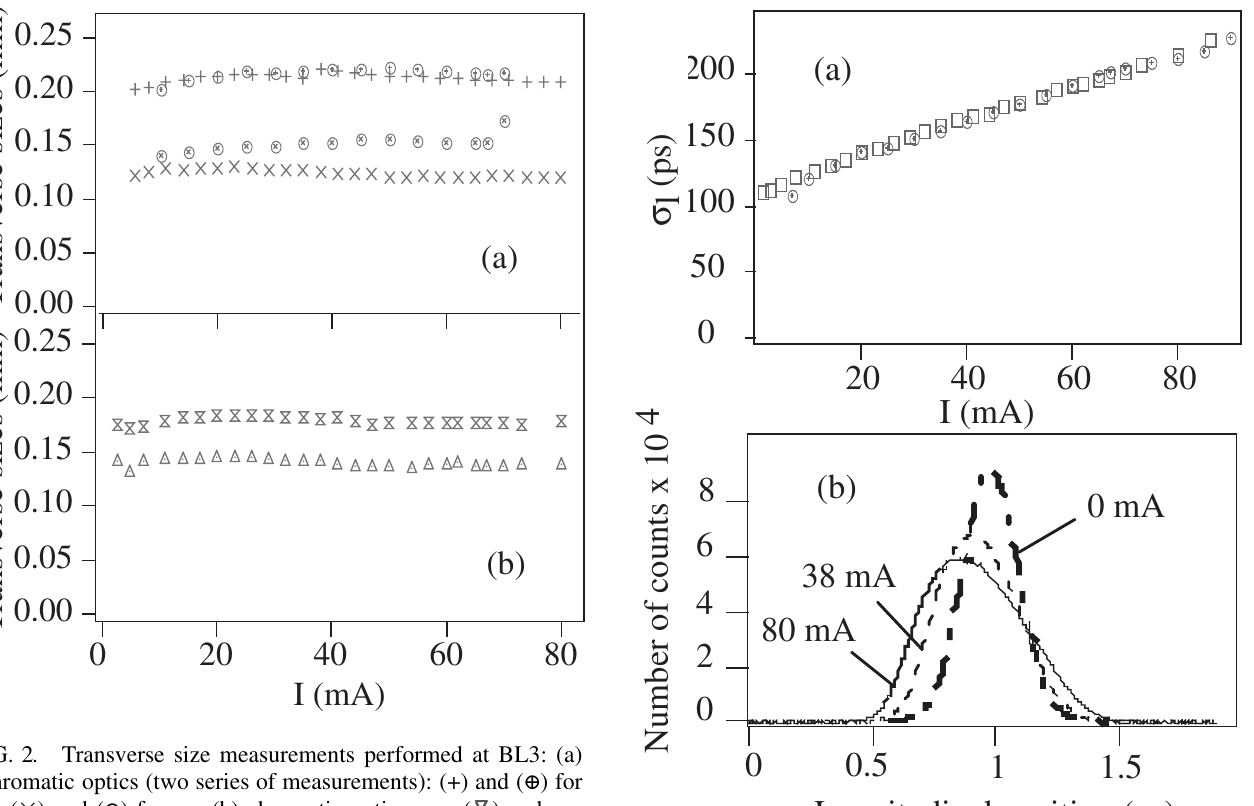
: ( ) and (cid:2) : x z FIG. 3. (a) The rms bunch length versus current, in the achro- matic ( (cid:10) ) and chromatic ( (cid:1) ) cases with FEL off, measured with a double sweep streak camera Hamamatsu C5680. (b) Evolution of the electron beam longitudinal profile for different currents (chromatic case) with FEL off (data analysis from streak camera Hamamatsu C5680 images). Continuous line: I (cid:6) 80 mA , dashed line: I (cid:6) 38 mA , dotted and dashed line: I (cid:6) 0 mA . p (cid:5) , where w (cid:6) (cid:1)(cid:1)(cid:1)(cid:1)(cid:1)(cid:1)(cid:1)(cid:1)(cid:1)(cid:1)(cid:1)(cid:1)(cid:1)(cid:1)(cid:1)(cid:1)(cid:1)(cid:1)(cid:1)(cid:1)(cid:1)(cid:1)(cid:1)(cid:1)(cid:1)(cid:1)(cid:1)(cid:1)(cid:1)(cid:1)(cid:1)(cid:1)(cid:1)(cid:1)(cid:1)(cid:1)(cid:1)(cid:1)(cid:1)(cid:1) (cid:4) e(cid:7)V (cid:5) = (cid:4) T =w w E (cid:5) (cid:7)c (cid:4) (cid:2) is the syn- (cid:3) 0 S S RF RF 0